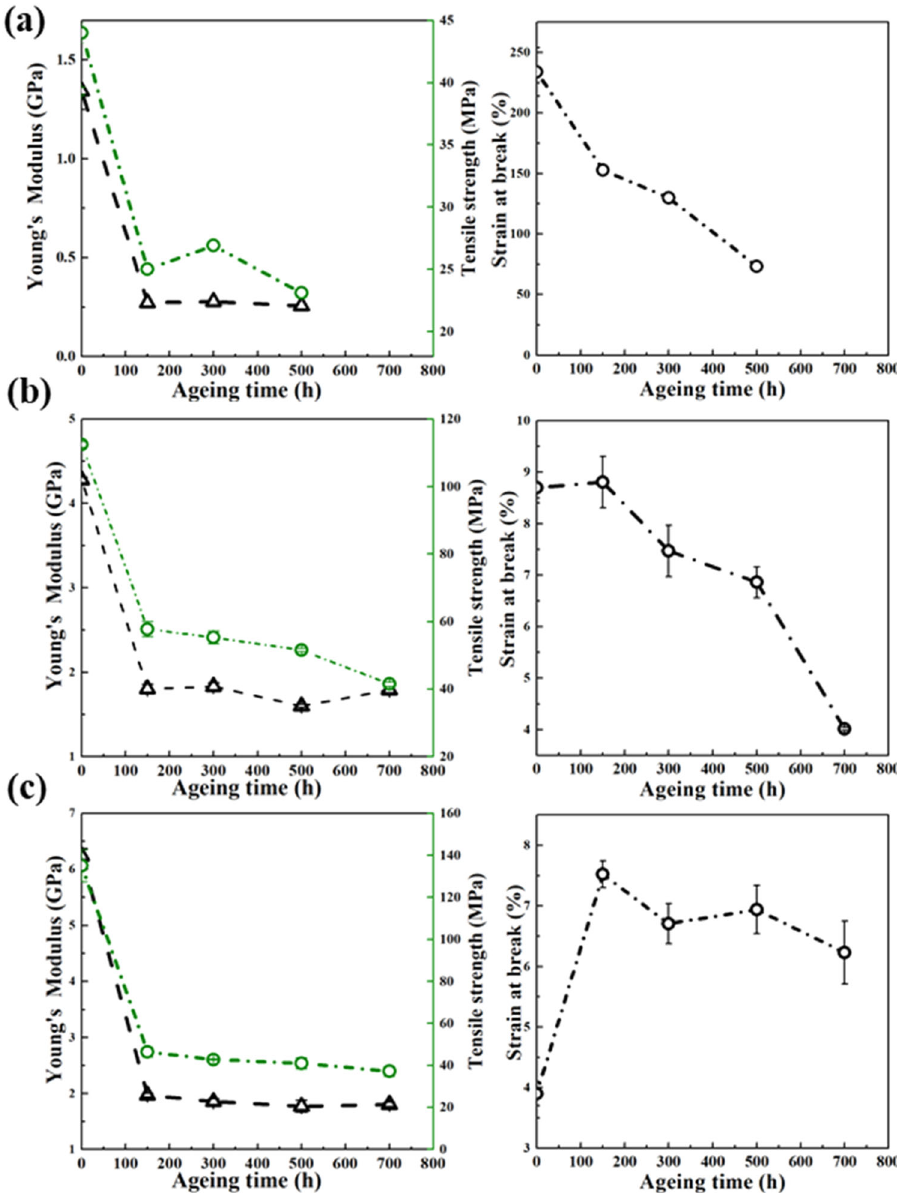
Fig. 7 Changes in mechanical properties of the samples during ageing. Young ’ s modulus, tensile strength, and strain at break of the unaged and aged PA12 ( a ), GF23-PA12 ( b ), and GF30-PPA ( c ) samples. The unreinforced PA12 sample aged for 700 h was not tested due to it being damaged by the severe cracking (see Fig.